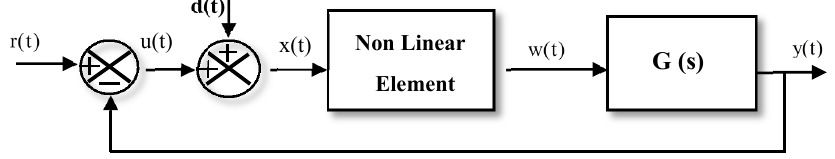
Figure 1. Nonlinear system with dither applied.